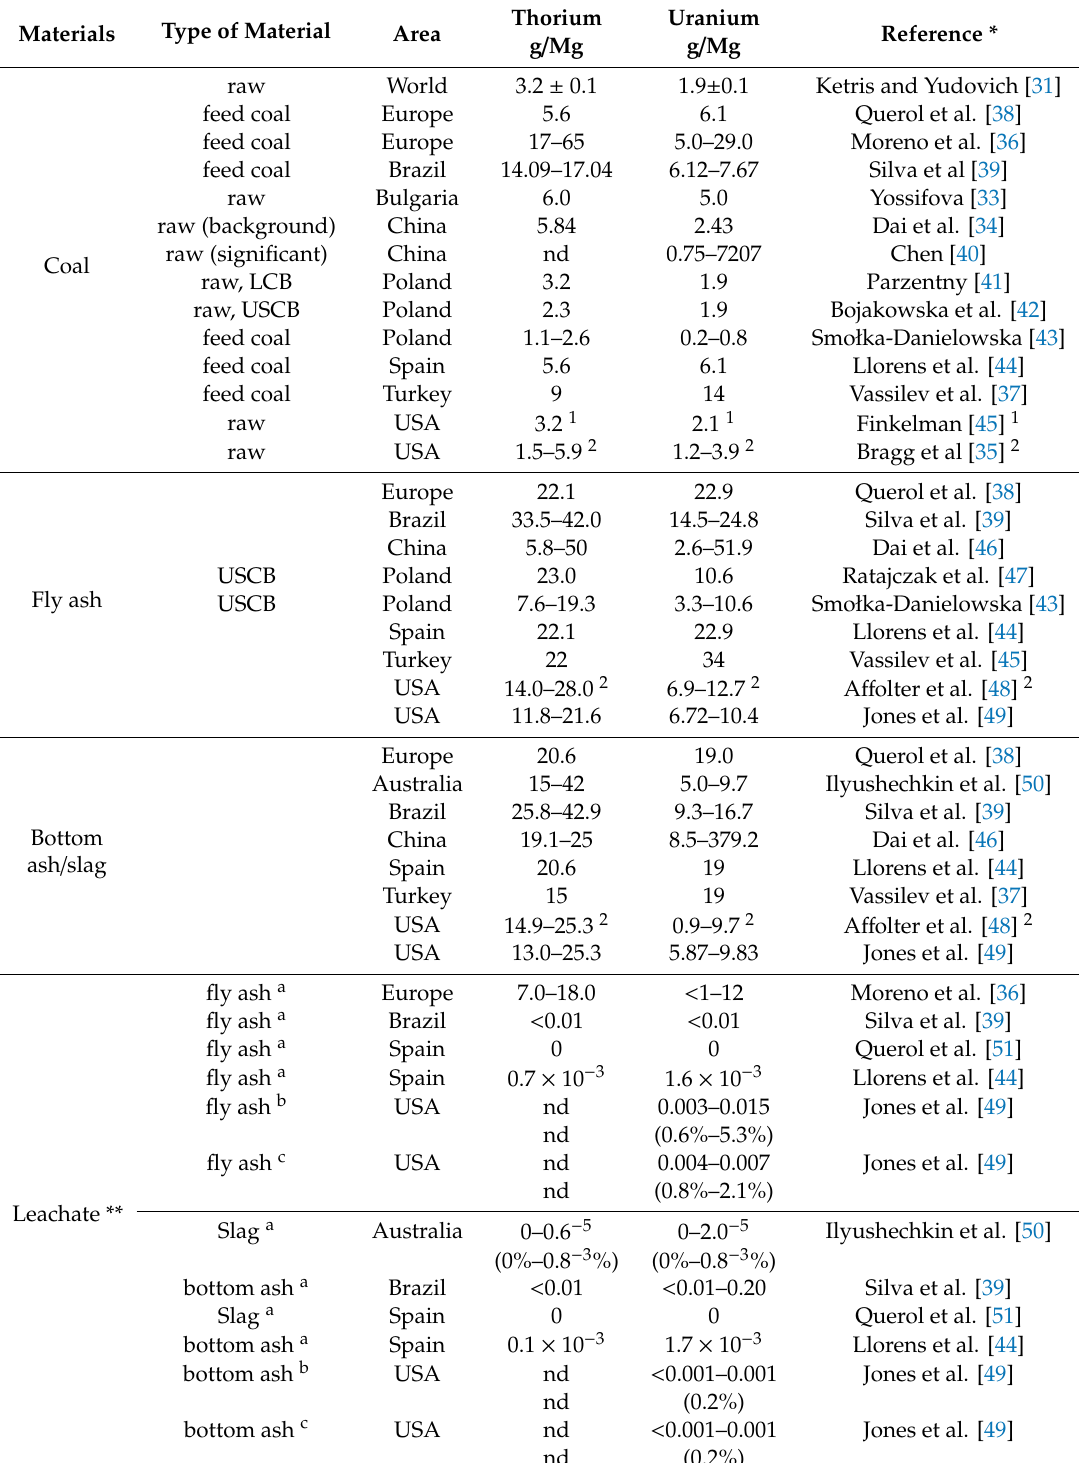
Table 5. U and Th in the selected world’s bituminous coal / feed coal, fly ash, bottom ash, slag and eluates, and leaching e ffi ciency (in